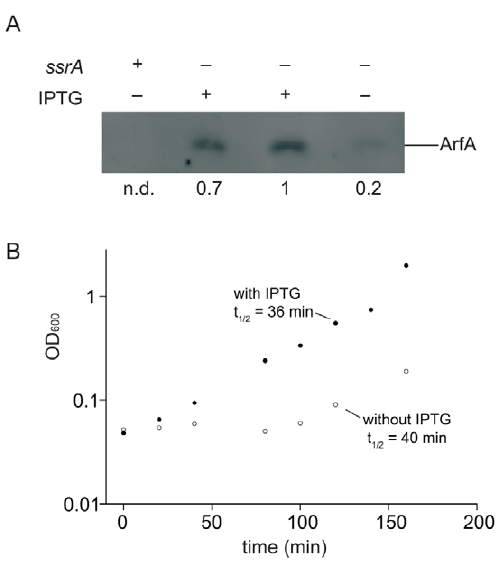
Figure 3. ArfA is expressed in cells containing pCA24N-His 6 -ArfA . ( A ) Western blots to determine the expression of ArfA in wild-type S. flexneri (lane 1), S. flexneri ssrA::kan pCA24N-His 6 -ArfA grown with IPTG at all times (lane 2), grown without IPTG and diluted into medium containing IPTG (lane 3), and grown without exposure to IPTG (lane 4). The amounts of ArfA relative to lane 3 are shown (n.d.: not detectable). ( B ) Growth of S. flexneri ssrA::kan pCA24N-His 6 -ArfA with IPTG (closed circles) and with no IPTG (open circles) monitored by optical density at 600 nm. Doubling times during exponential growth (80–160 min) are